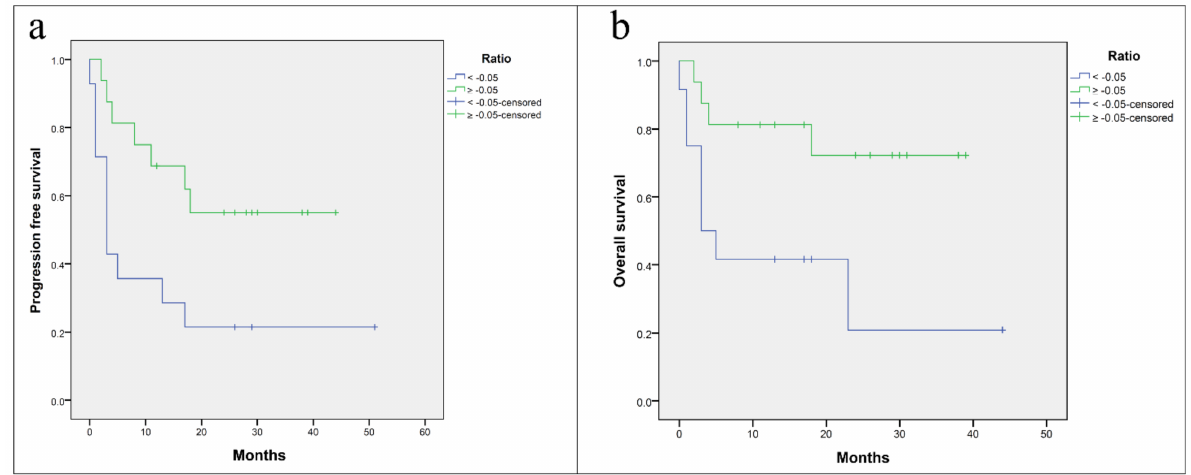
Figure 4. Kaplan–Meier curves. Correlation between progression-free survival ( a ) and overall survival ( b ) with ratio (cut-off: −